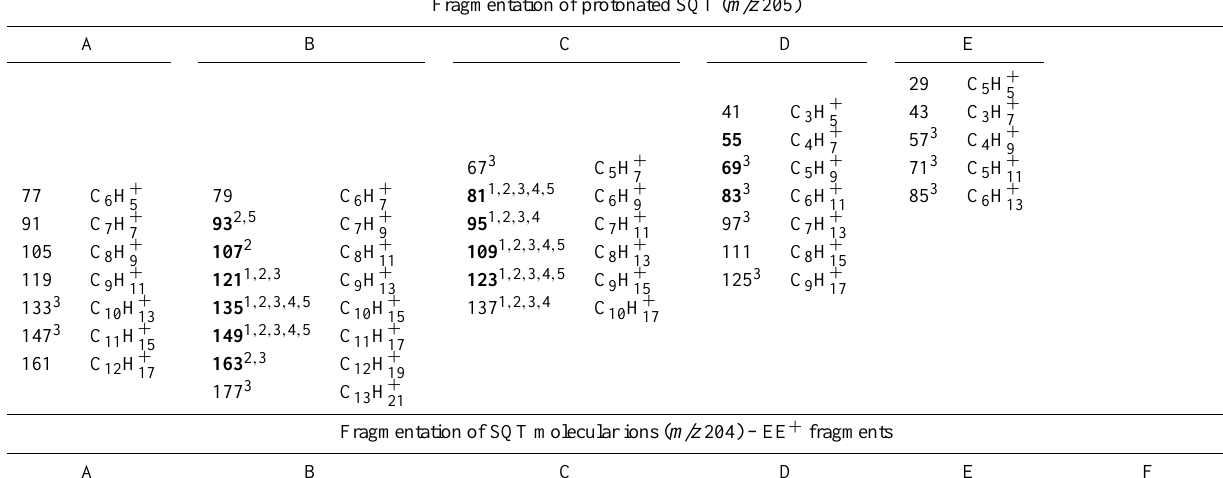
Table 1. Families of fragments from the fragmentation of m/z 205 and m/z 204. In bold: fragment ions with a maximum fragmentation fraction > 10%. For the fragmentation of ions at m/z 204, EE + and OE •+ fragments are distinguished. Fragmentation of protonated SQT ( m/z